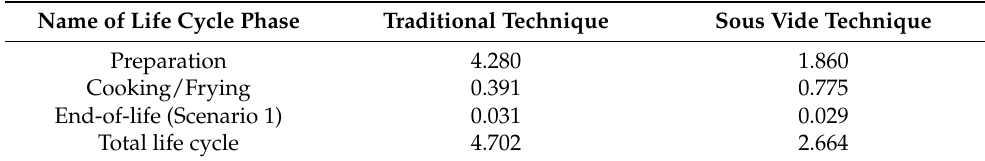
Table 5. Global warming potential in the life cycle phases in nanograms (functional unit: one